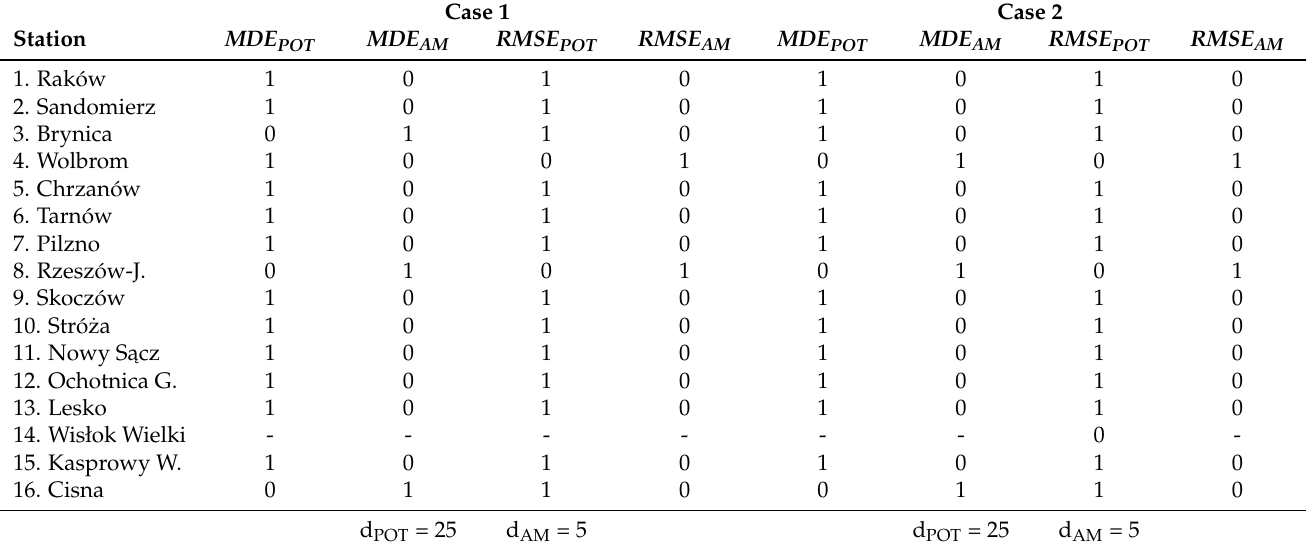
Table 6. The scores d 1 , d 2 assigned to the stations based on the comparison between the MDE and RMSE from the POT and AM methods. The number 1 shows a better fit. The final score d is shown under the